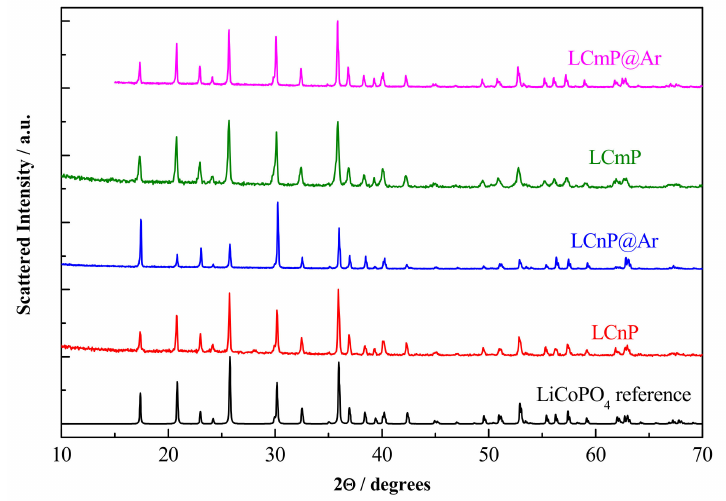
Figure 2. Patterns of the substituted samples before and after annealing under Ar. LiCoPO 4 pattern is also reported as a reference.